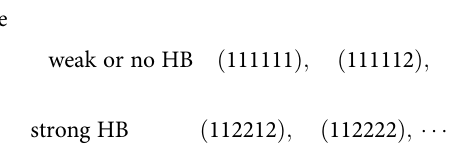
eigenstates can belong to a given peak in the spectrum. The variation of the local environment leads to a variation in the eigenvalue distribution, which depends on the shape of the OH PEC: There is only one vibrational level within each peak for the steep potentials (weak or no-HB), the only exception being the peaks with m ≥ 6 (see Eq. (1) and Fig. 3d). In contrast, two vibrational levels of a shallow potential (HB) can lie within the